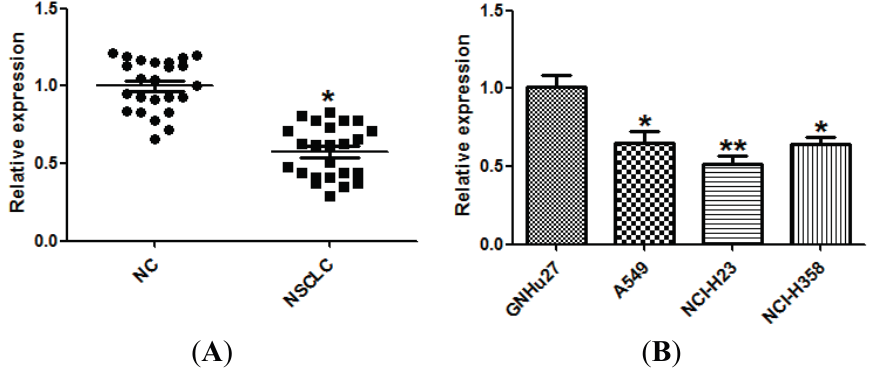
Figure 1. Down-regulation of miR-143 in non-small cell lung cancer (NSCLC) tissues and cell lines. ( A ) The expression of miR-143 in 24 pairs of NSCLC tissues and the matched normal lung tissues (NC) was measured by quantitative real time PCR (qRT-PCR); and ( B ) The expression of miR-143 in normal lung epithelial cell line (GNHu27) and 3 NSCLC cell lines (A549, NCI-H23, and NCI-H358) was measured by qRT-PCR. * p < 0.05, ** p < 0.01 compared with control.